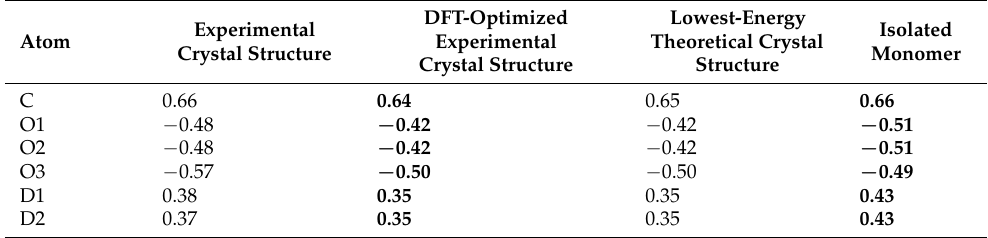
Table A7. Wavefunction-based Löwdin atomic charges of carbonic acid extracted from plane waves for the experimentally determined crystal structure, the DFT-optimized experimental crystal structure (in bold face, see text), the lowest-energy theoretical crystal structure, and the isolated monomer (in bold face, see